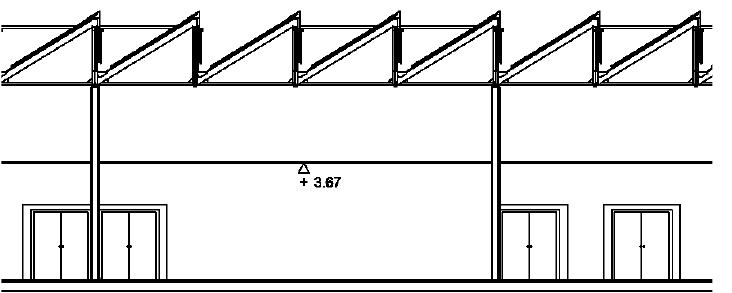
Figure 3. Plan of the cross-section of the Leonardo da Vinci building of the Rabanales University Campus of the University of Córdoba (Spain).